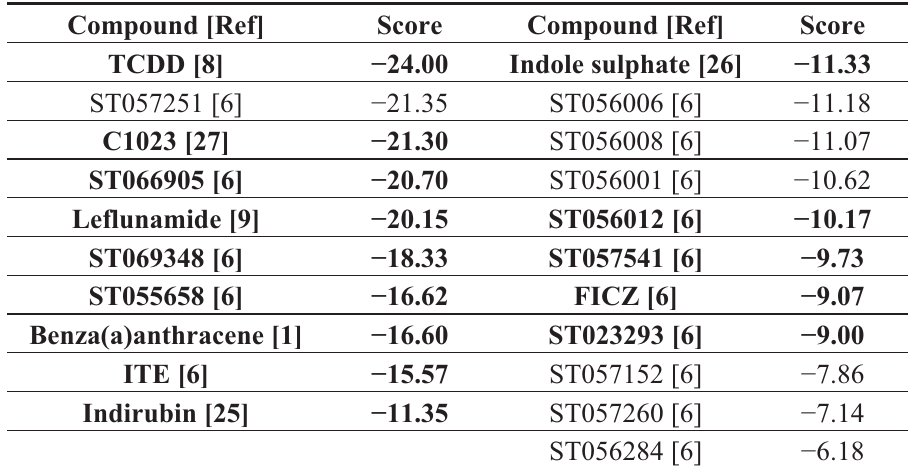
Table 1. Docking results from the Virtual Ligand Screening (VLS) of the benchmark database into the agonist-optimized model a,b